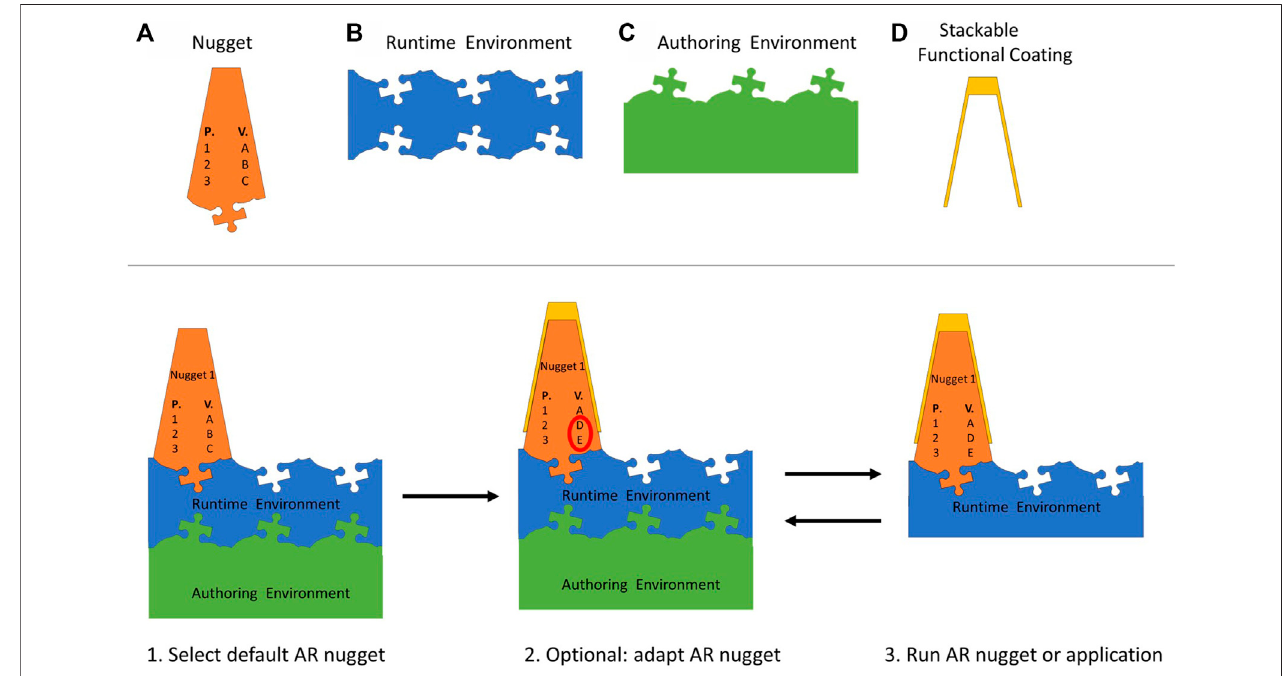
FIGURE 1 | Top: Visualization of components from the AR nugget system design. Bottom: Conceptual AR nugget authoring work fl ow based on the components. Authors select an AR nugget, can adapt the parameters ’ (P.) values (V.), and run the AR nugget.